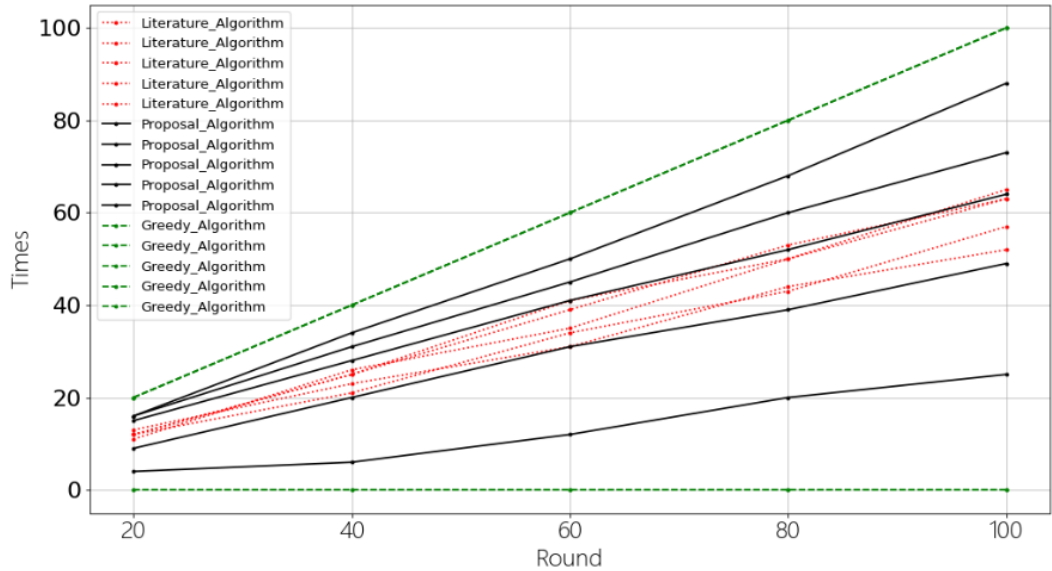
Figure 6. Comparison of algorithms under different reputation values.